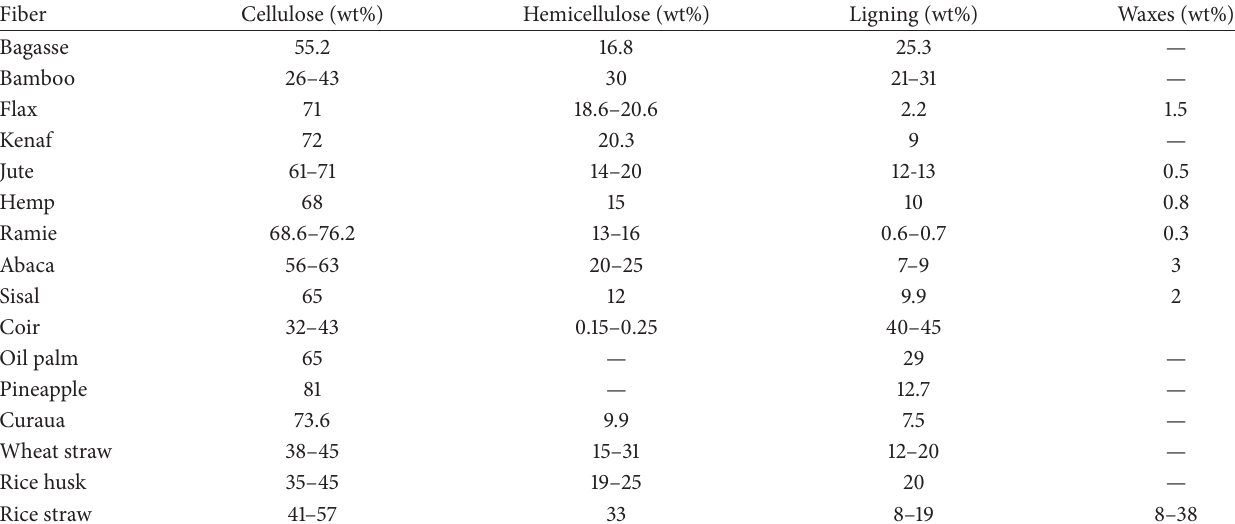
Table 2: Chemical composition of some common natural fibers